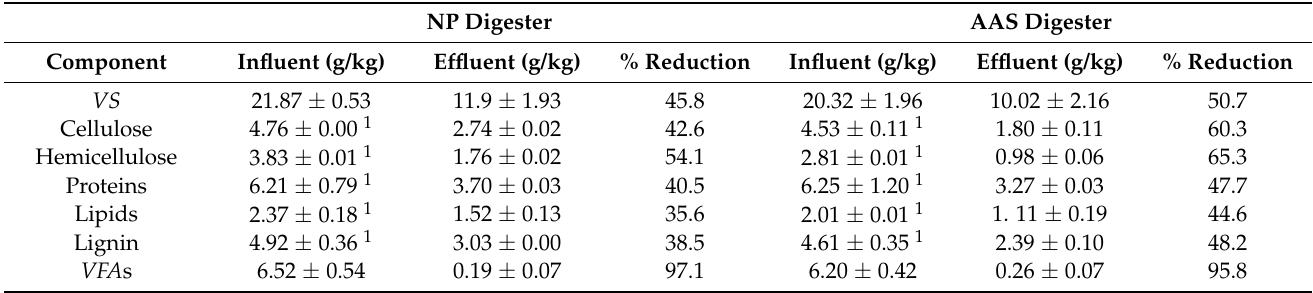
Table 3. Concentration of major organic components of influents and effluents of digesters and reduction efficiency of anaerobic digestion (AD) (data correspond to samples taken during 70–80 days digestion). NP Digester AAS Digester